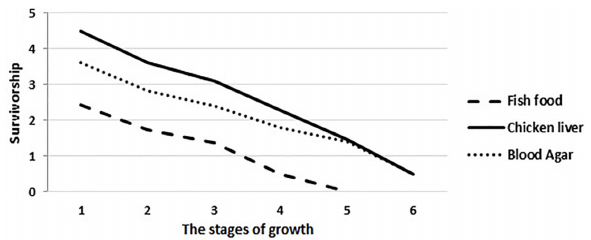
Figure 1. Survivorship Curve of L. sericata Based on life Expectancy